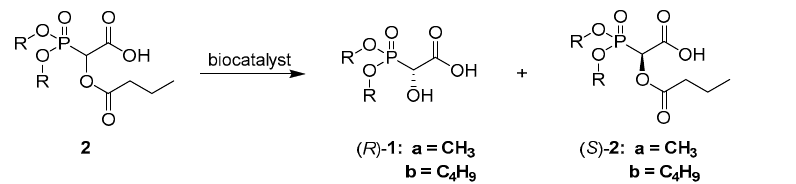
Table 1. Lipase-catalyzed hydrolysis of dimethyl 1-butyryloxy-1-carboxymethylphosphonate 2a . Table 2. Lipase-catalyzed hydrolysis of dibutyl 1-butyryloxy-1-carboxymethylphosphonate 2b . Lipase Time Lipase